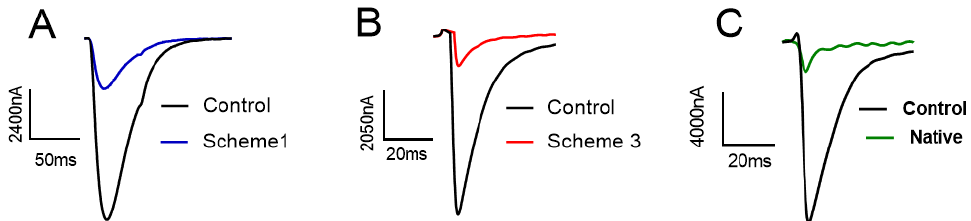
Figure 11. Current diagrams of KIIIA synthesis products using Scheme 1 and Scheme 3 ( A , B ) and their effects on blocking sodium channels at 1 µM concentration compared to natural isomers as controls ( C ).